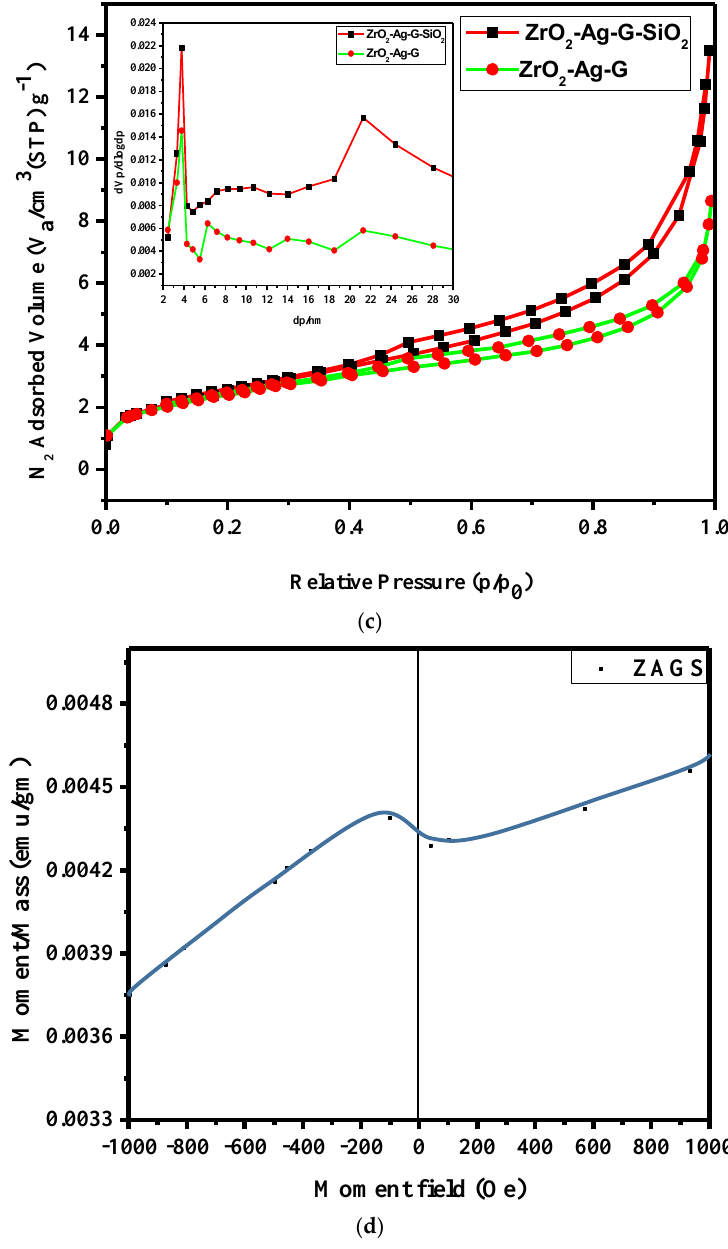
Figure 4. ( a ) Raman spectra of ZS, ZrO 2 -Ag, ZrO 2 -Ag-G, and ZrO 2 -Ag-G-SiO 2 sample, ( b ) Nitrogen adsorption-desorption isotherms of ZrO 2 -Ag-G, ZrO 2 -Ag-G-SiO 2 ; and the corresponding pore size distributions (inset), ( c ) DRS data of ZrO 2 -Ag, ZrO 2 -Ag-G, ZrO 2 -Ag-G-SiO 2 and ( d ) Magnetic field area of ZrO 2 -Ag-G-SiO 2 .